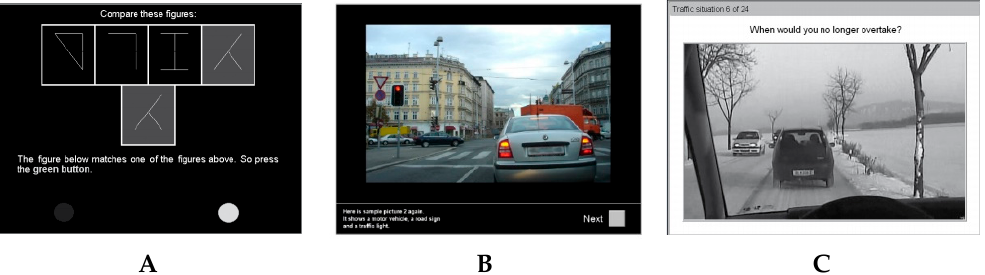
Figure 1. Examples of the driving-related tasks of the Vienna Test System TRAFFIC. From the left to the right: ( A ) the selective attention test (COG S / 11); ( B ) the tachistoscopic perception test (ATAVT